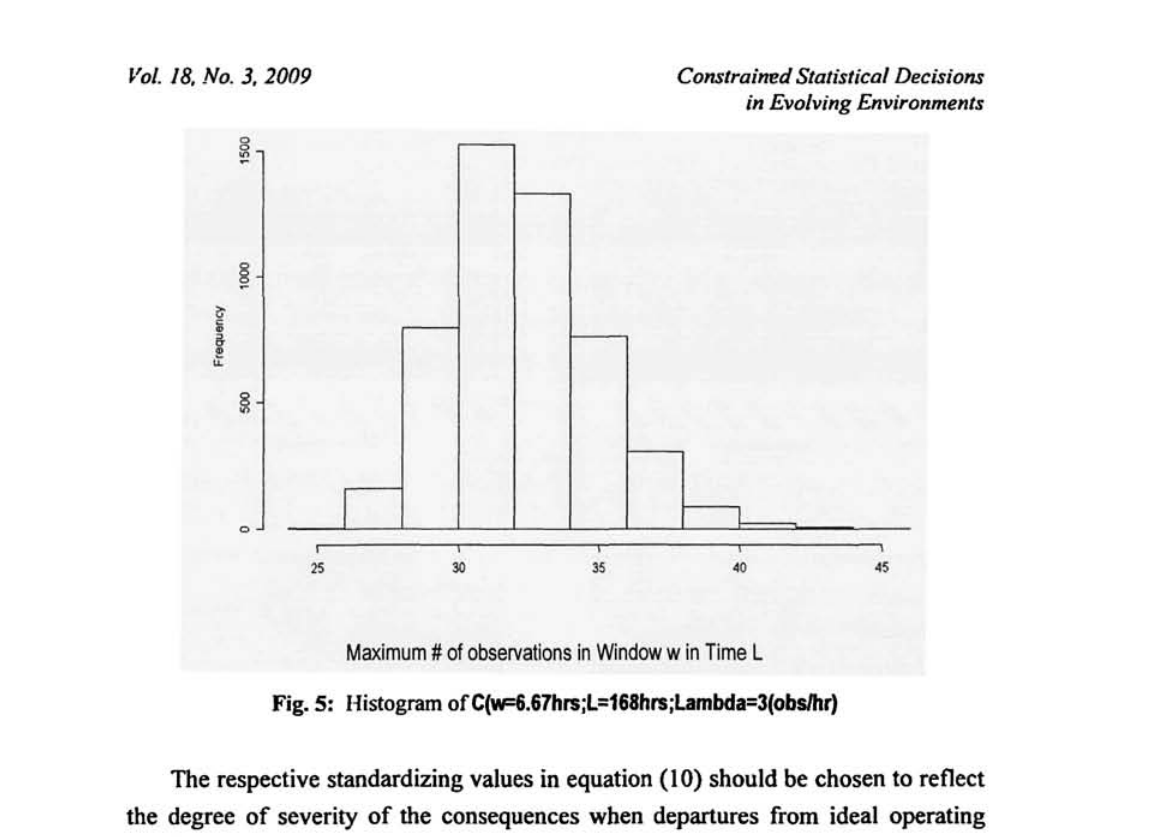
Fig. 5: Histogram of